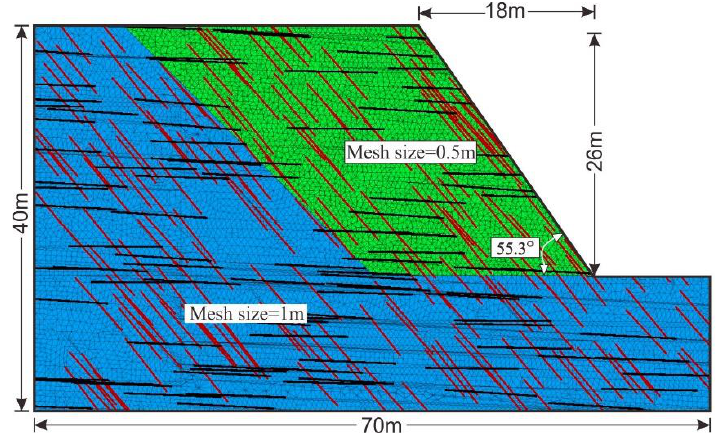
Figure 3. The slope model with random fractures.